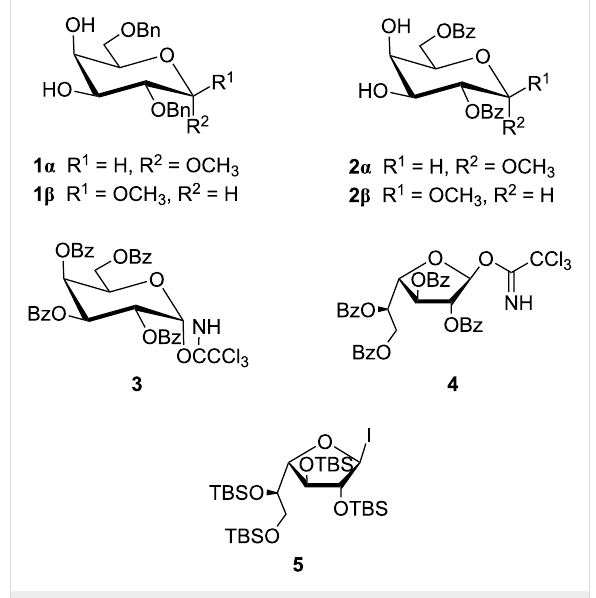
Figure 1: Studied glycosyl acceptors and